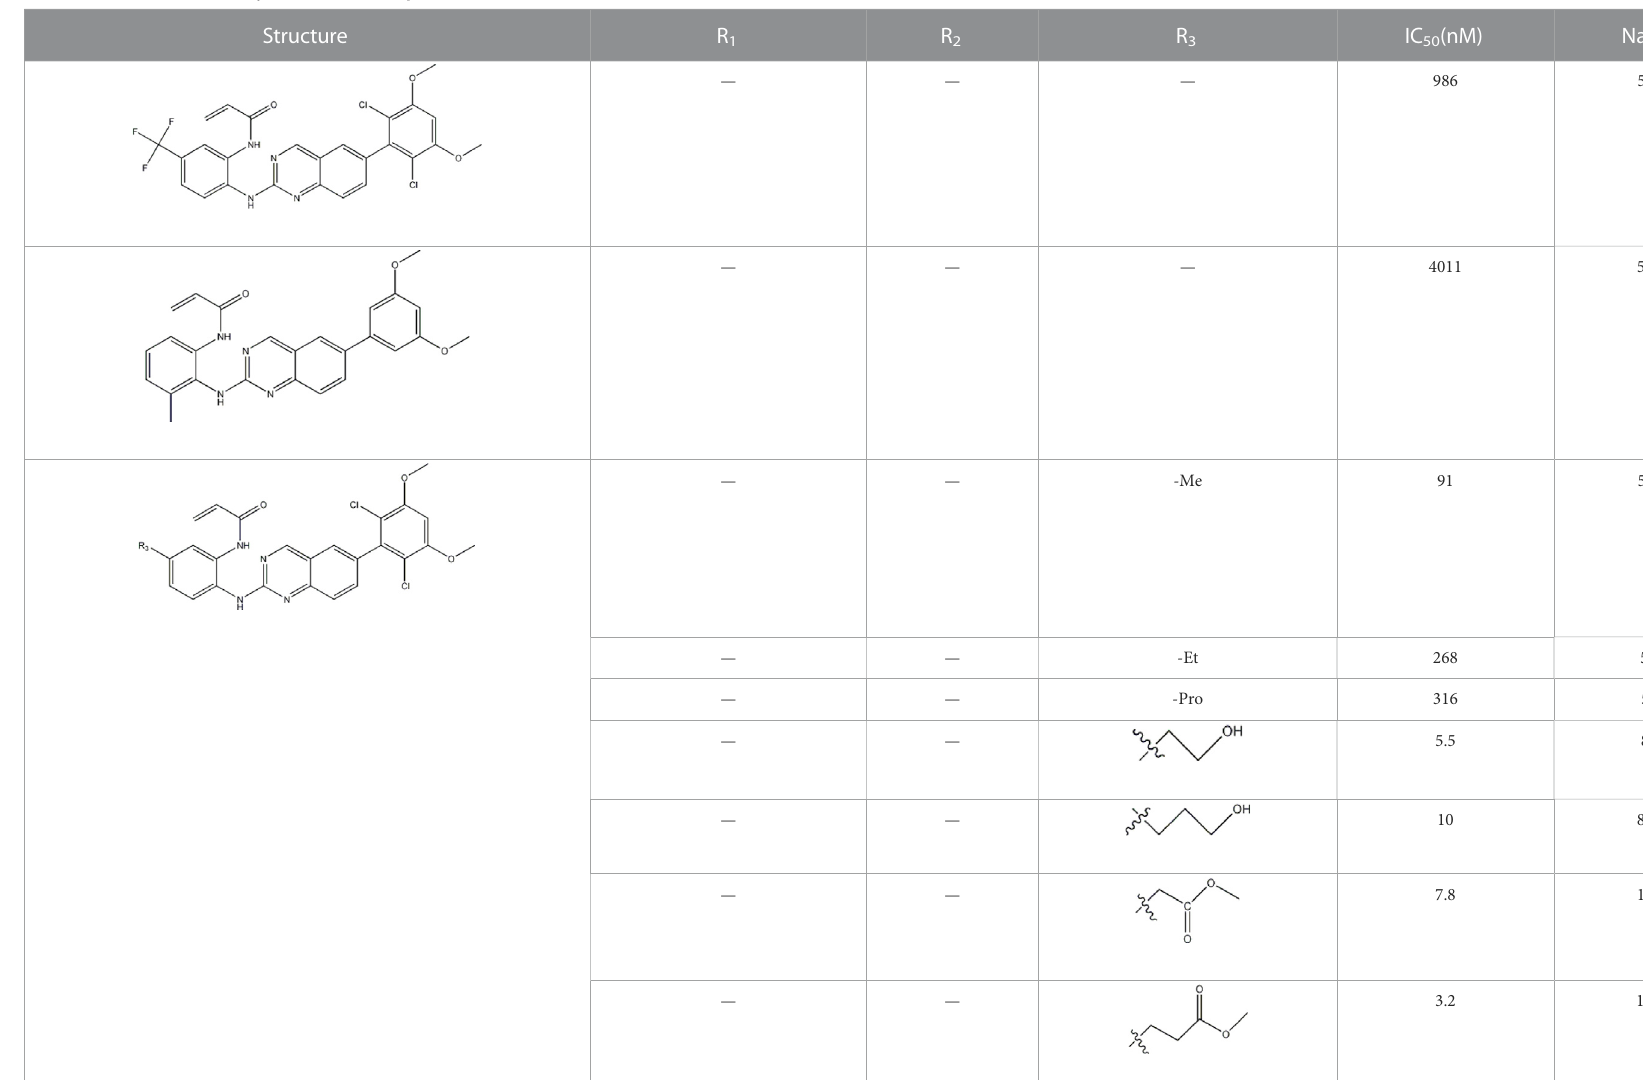
TABLE 1 Structure and activity values of 37